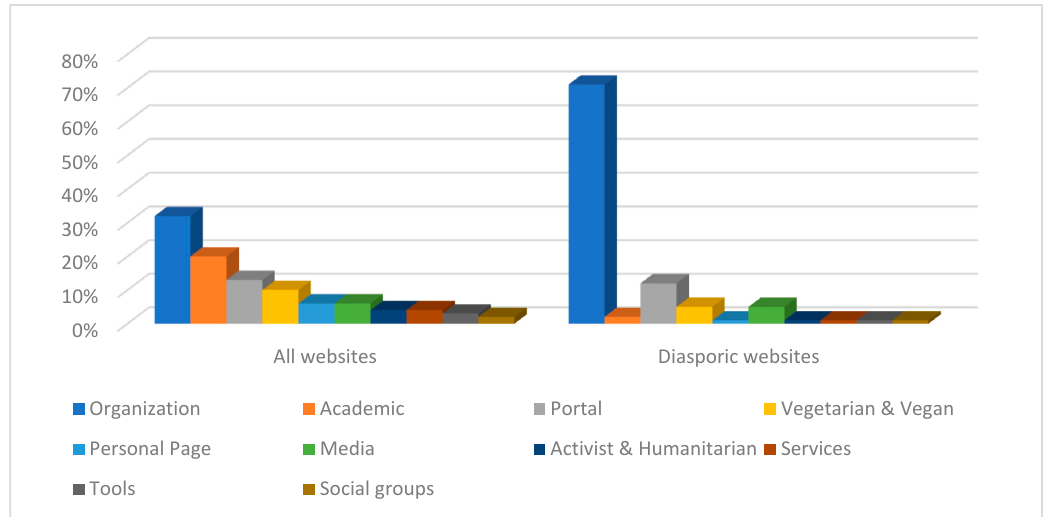
Figure 3. Categories of websites and their distribution for the 2017 website corpus (left) and for the diasporic subcorpus (right).